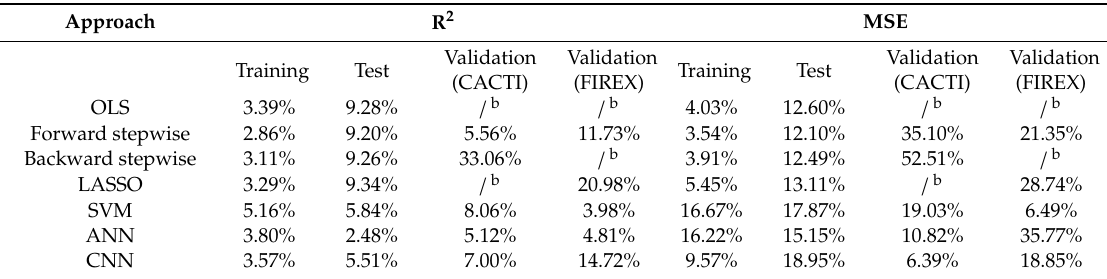
Table 5. The relative standard deviation of R 2 and MSE derived by the bootstrap resampling